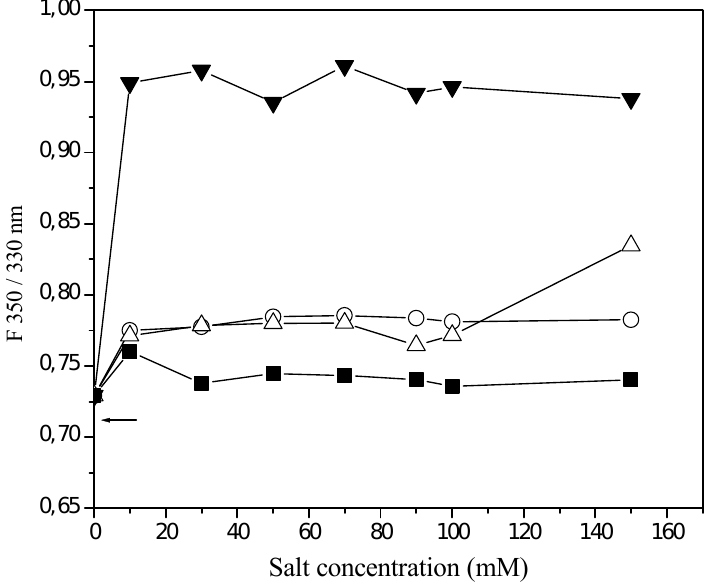
Figure 6. Effect of Hoffmeister series ions on Dtxd intrinsic fluorescence. Soluble samples of 7.36 mM Dtxd were obtained after its emulsification in the presence of CH kosmotropics NaHPO (o) and NaCl ( ∆ ) or the chaotropics KSNC ( (cid:132) ) and MgCl 4 the fluorescence spectra were